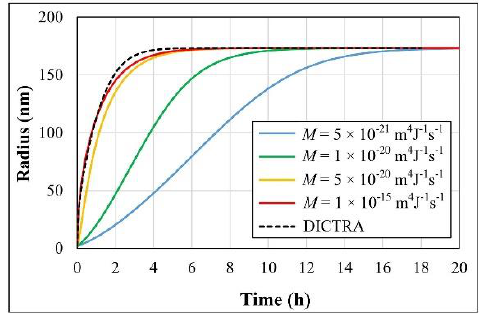
Figure 6. Size evolution of a spherical θ -Al 2 Cu growing in a finite Al-1.0 at%Cu matrix with four different values of the interfacial mobility. The number density of the precipitates is assumed to be 1.0 × 10 18 m −3 .